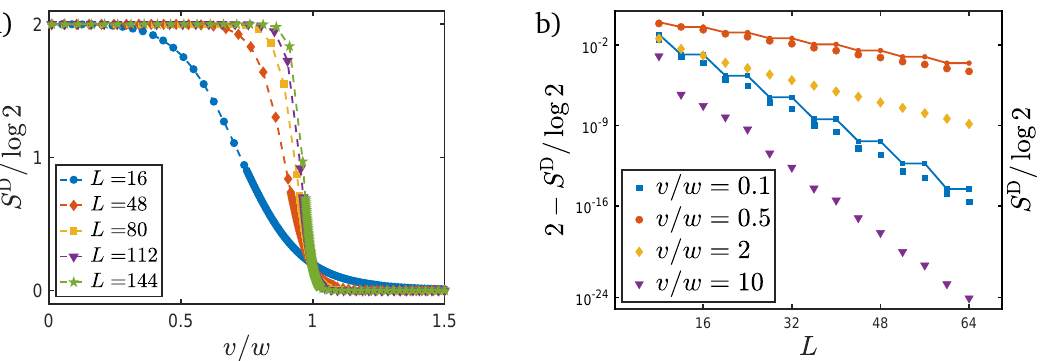
Figure 2: (Color online) a) S D as a function of the ratio v / w and the total length L = 2 L = 4 L for L = 2 L . The critical point is at v / w = 1. S D is non-zero for the A B D topological phase, and zero outside: S D qualifies as a good topological detector. b) Scaling behavior of S D towards its quantized convergence value. For the topological phase (left y -axis; v / w = 0.1 and 0.5 resp. squares and dots), S D converges to 2log2. For the non-topological phase (right y -axis; v / w = 2 and 10 resp. diamonds and triangles), S D converges to zero. The increments on both the left and right y -axis are the same. The scaling behavior of S D is exponential with the size of the chain = 2 L = 4 L L = 2 L for parameters in both phases. The results of the simulations A B D (scattered points) agree with the analytic approximations of Sec. 3 (full lines). The saw-teeth variations of the latter are due to the alternating sign in Eqs. 14a and 14b. ( v / w > 1). S D (as in Eq. 11) is found identical, up to minor quantitative changes close to the 2 phase